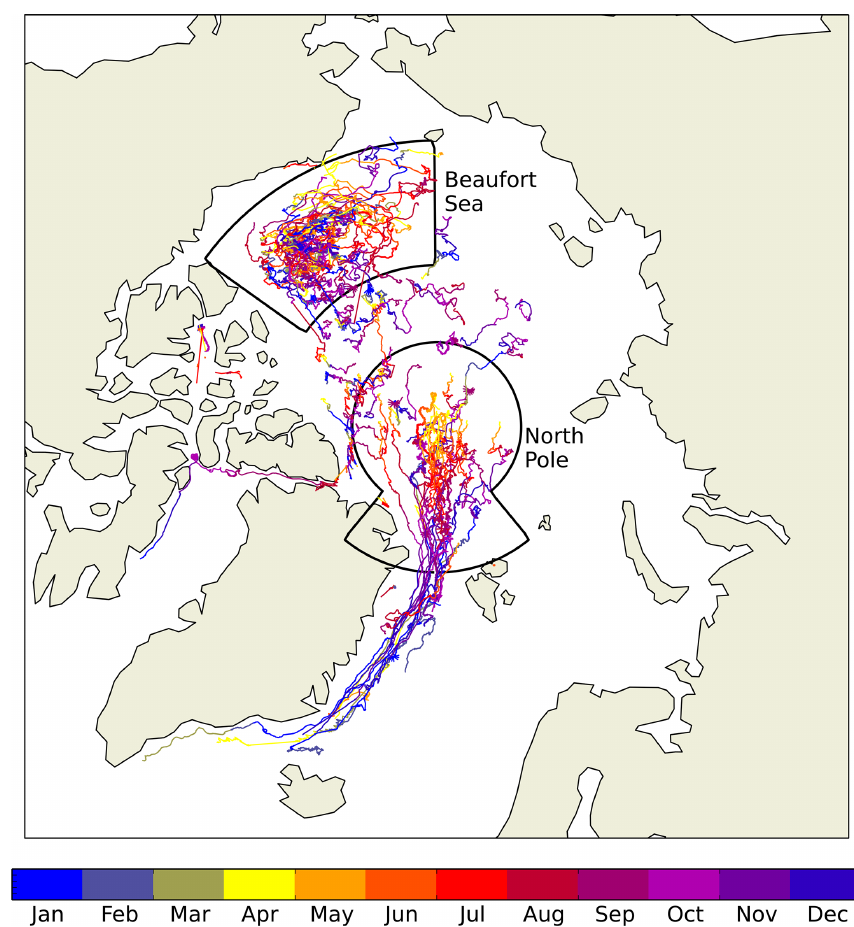
Figure 3. The tracks of Arctic ice mass balance buoys from 1993 to 2015, with months of coverage indicated by the coloured shading. The North Pole and Beaufort Sea regions used in the analysis are shown by the thin black